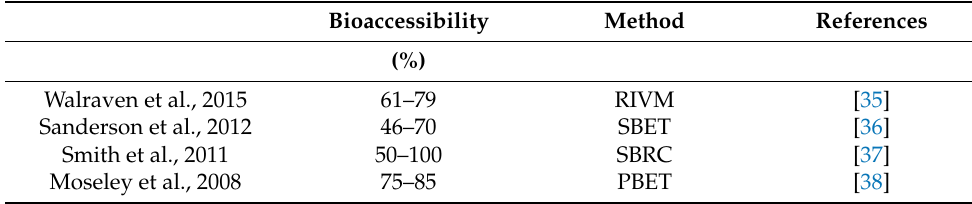
Table 2. Studies on the bioaccessibility of Pb in shooting